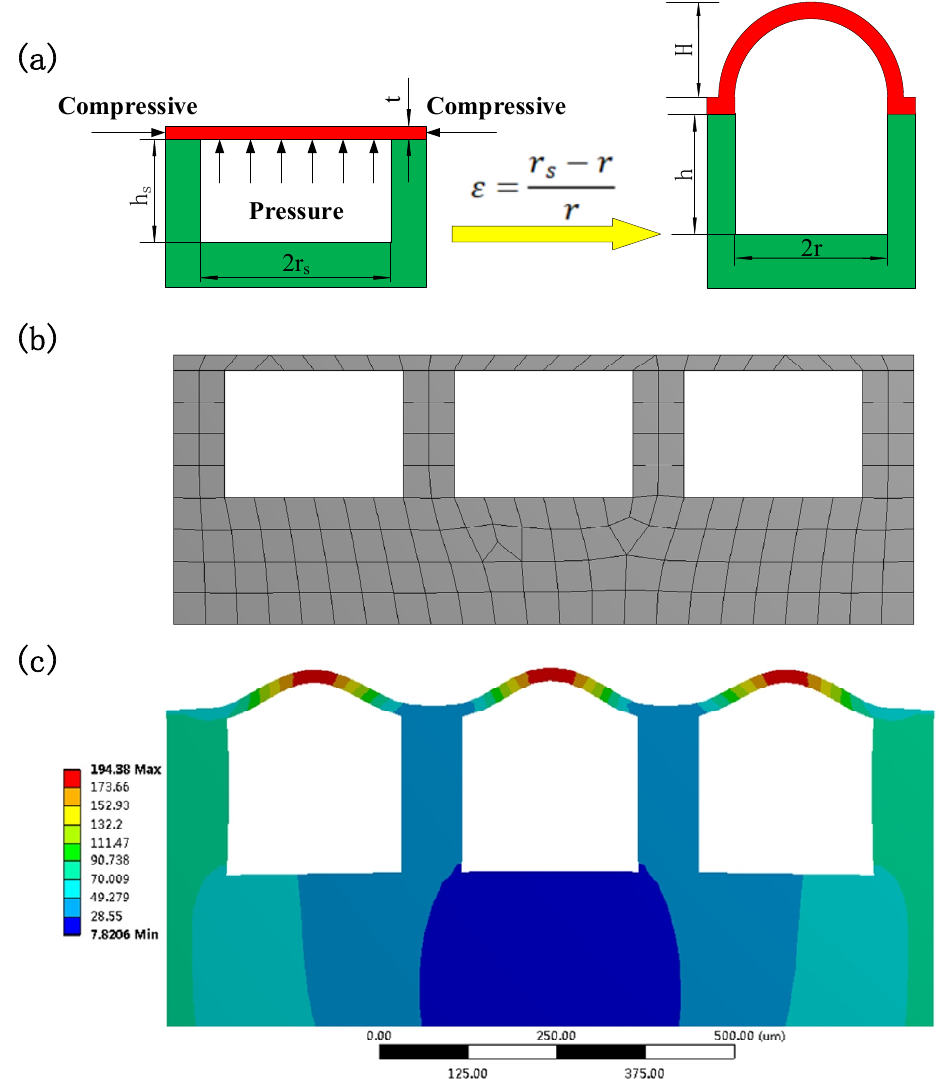
Figure 5. ( a ) Forces applied to an individual circular film when the prestrain is released ( left ), as well as the resulting film microstructure ( right ); ( b ) Finite element mesh used for numerical simulations; ( c ) Curved film microstructures obtained by using finite element simulation with the end face displacement and the pressure applied to the film. The color represents displacement ( μ m).